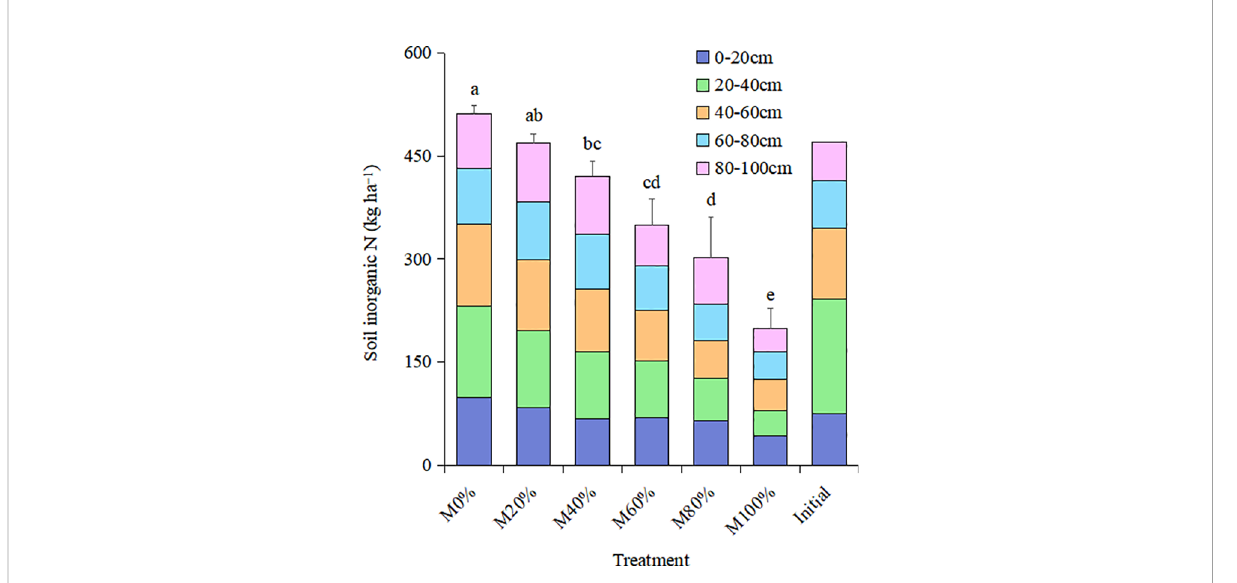
FIGURE 2 Soil inorganic nitrogen at harvest in 2020 at different soil layers with different organic substitution ratios of nitrogen